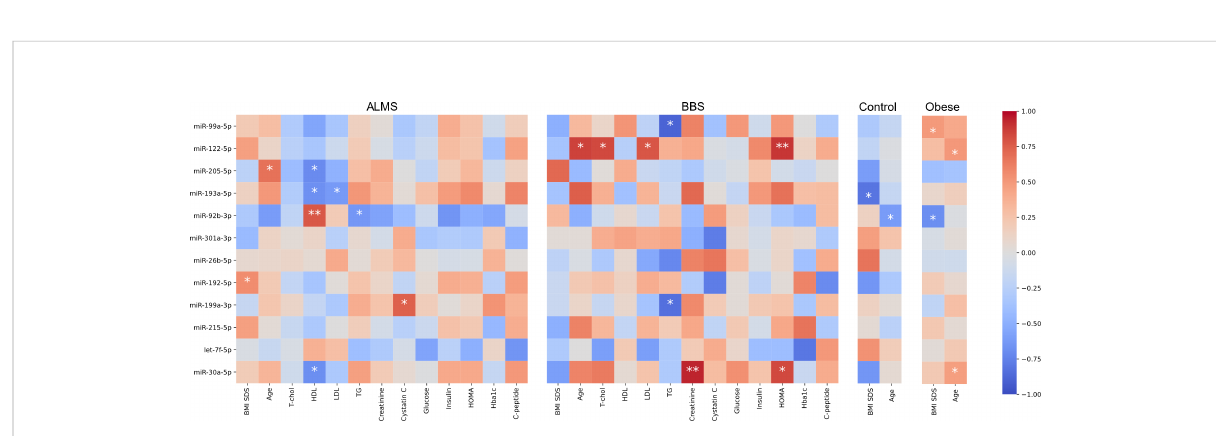
FIGURE 6 Correlations between miRNA expression (- D C t ) and clinical characteristics. Color represents value of Spearman correlation coef fi cient, * marks correlations with p<0.05 and **